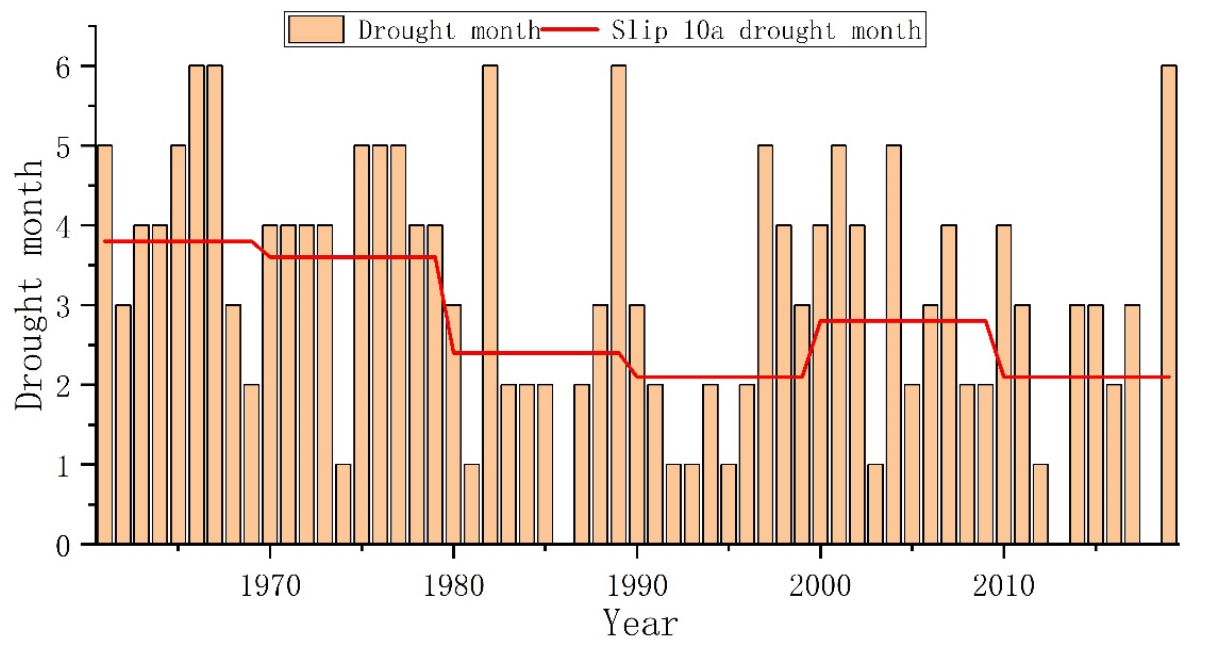
Figure 5. Number of drought months in different years.